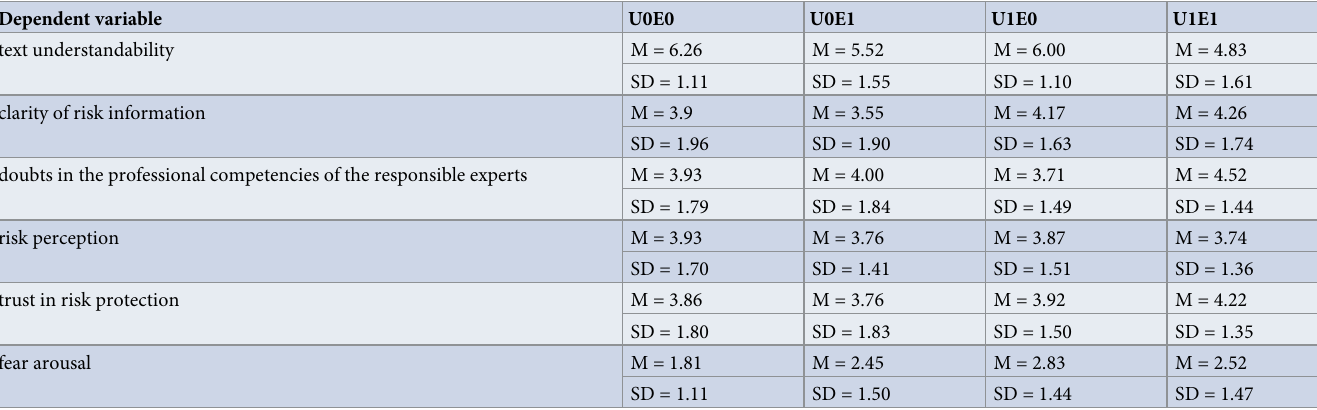
Table 5. Effects of uncertainty description about protection by risk management